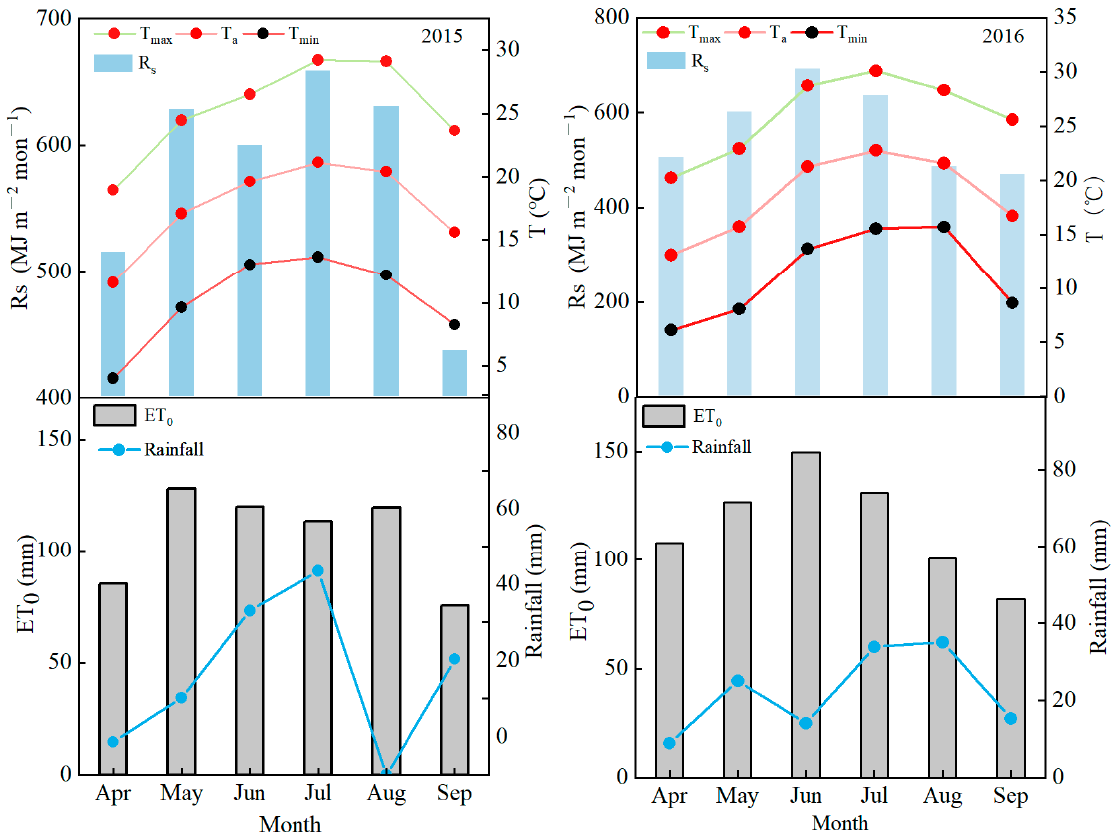
Figure 2. Monthly solar radiation, air temperature, reference evapotranspiration ( ET 0 ) and rainfall during the two growing seasons of spring maize in 2015 and 2016.